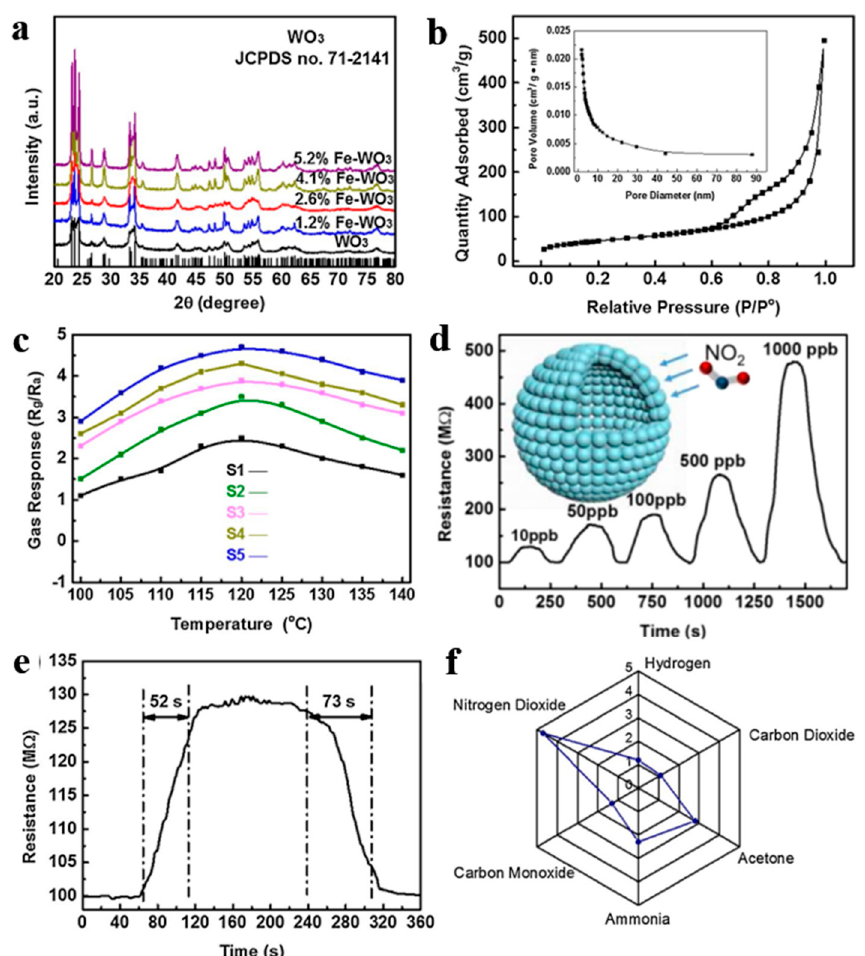
Figure 21. ( a ) XRD patterns. ( b ) N 2 adsorption and desorption isotherms and pore diameter distribution curves. ( c ) Response of all samples with different Fe doping contents from 100 to 140 °C to 1000 ppb NO 2 . The gas-sensing performance of the representative S5: ( d ) dynamic sensing curve to different NO 2 concentrations, ( e ) dynamic response curves to 10 ppb NO 2 at 120 °C, and ( f ) selective test to 1 ppm NO 2 versus several 10 ppm interfering gases. Reproduced with permission from [112]. Copyright Elsevier, 2018.